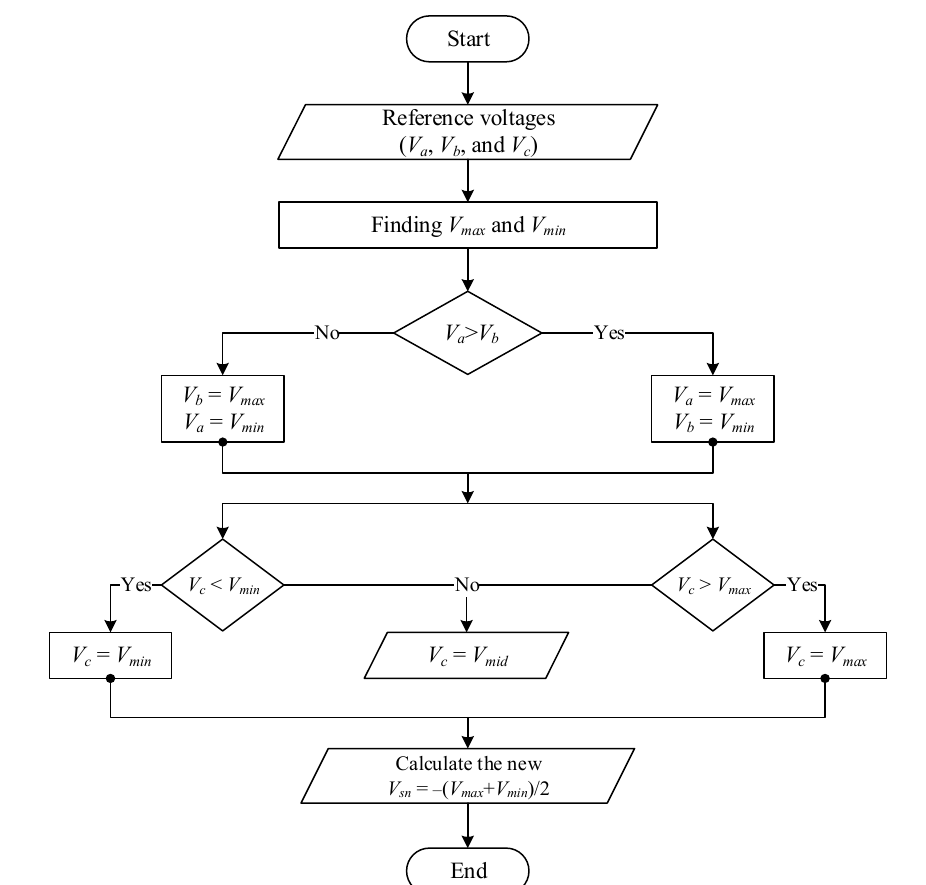
Figure 6. Proposed algorithm flowchart.